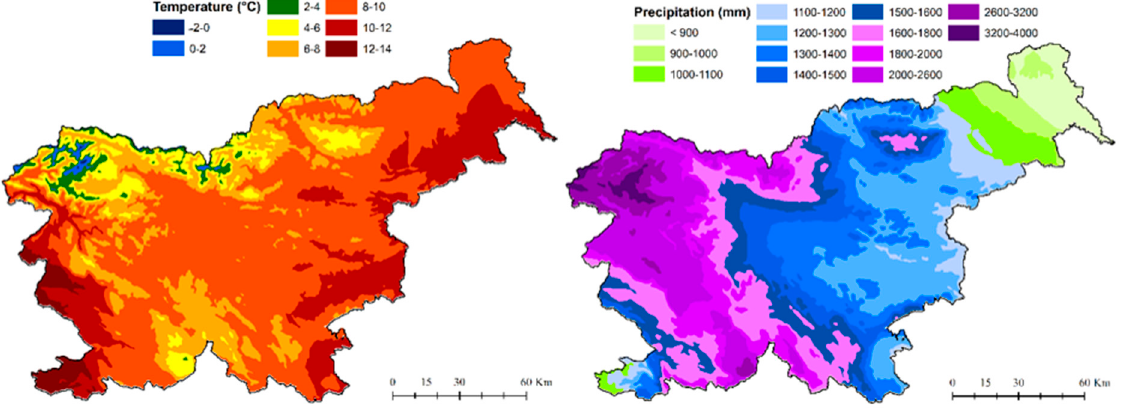
Figure 2. Mean annual temperature and mean annual precipitation across Slovenia in the period 1961–2010 (based on [45]).